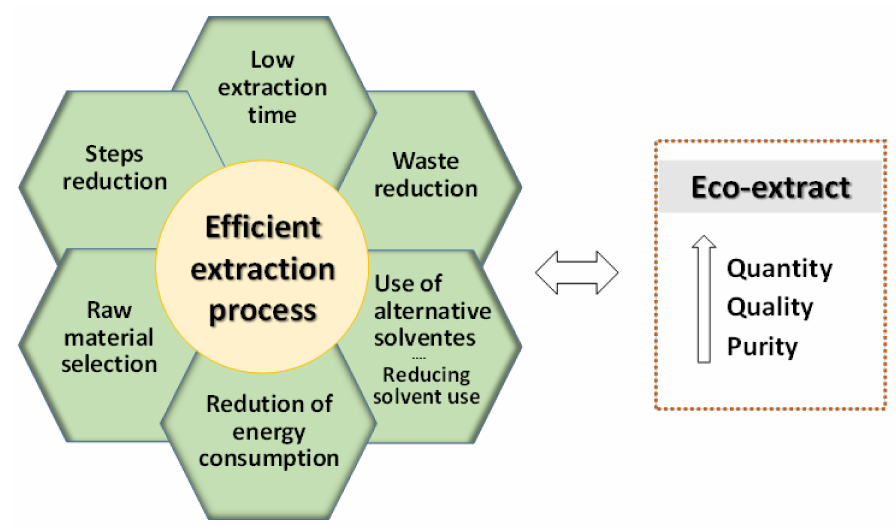
Figure 3. Principles of e ffi cient process for obtaining natural extracts. Adapted from Chemat et al.